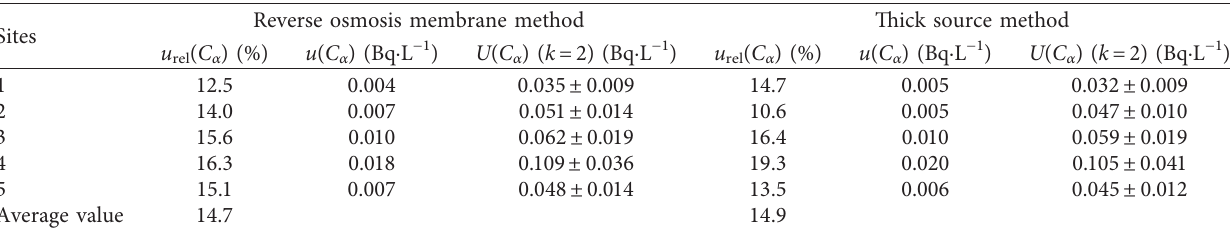
Figure 3: (a) The gross α -activity concentration of 5 water sources measured by thick source method and reverse osmosis membrane method, respectively; (b) the gross α -activity concentration of 5 water sources measured by thick source method and reverse osmosis membrane method, respectively. The gray bars indicate the relative errors of the two methods. The error bar was SD (standard deviation). The red dotted line is the identification of RMSE (root mean square Table 2: Measurement uncertainty of total α in each region.